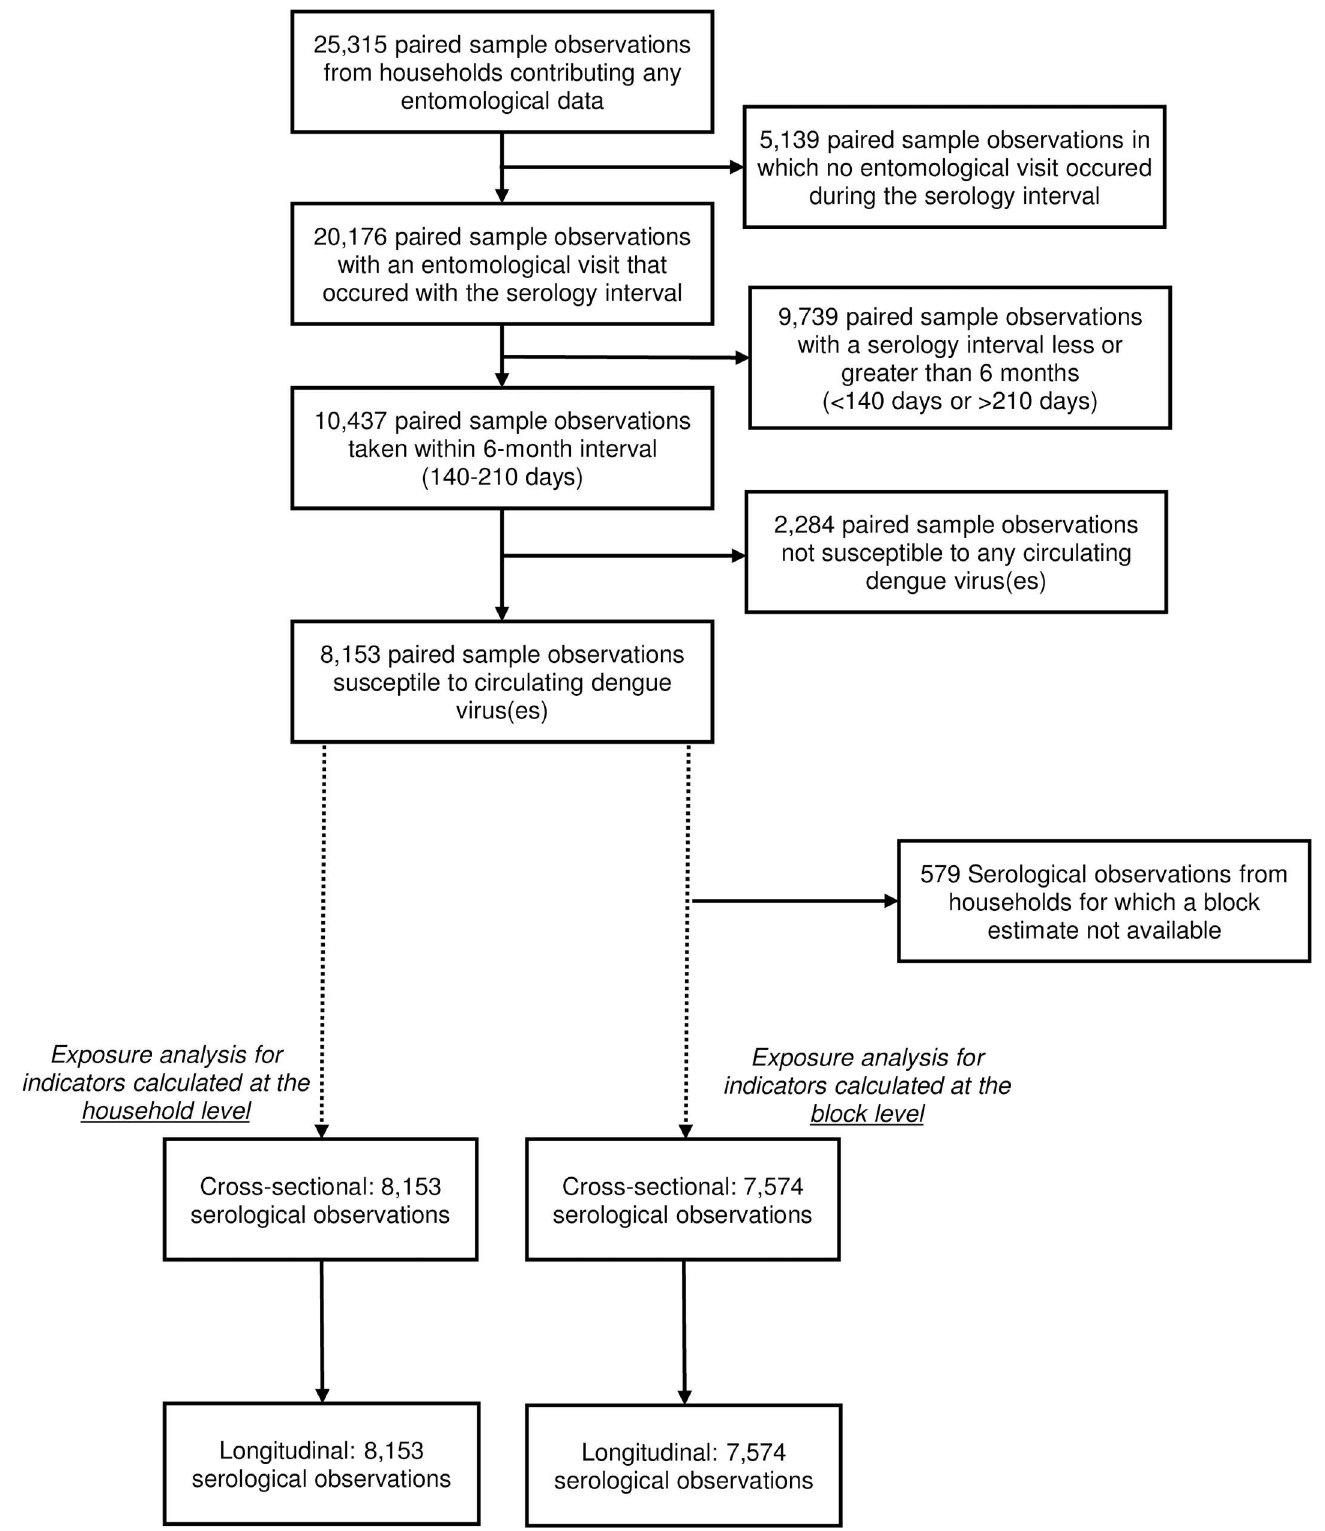
Fig 1. Construction of the Analysis Dataset. Fig 1 presents the constructionof the analyticalcohort based on inclusioncriteria.